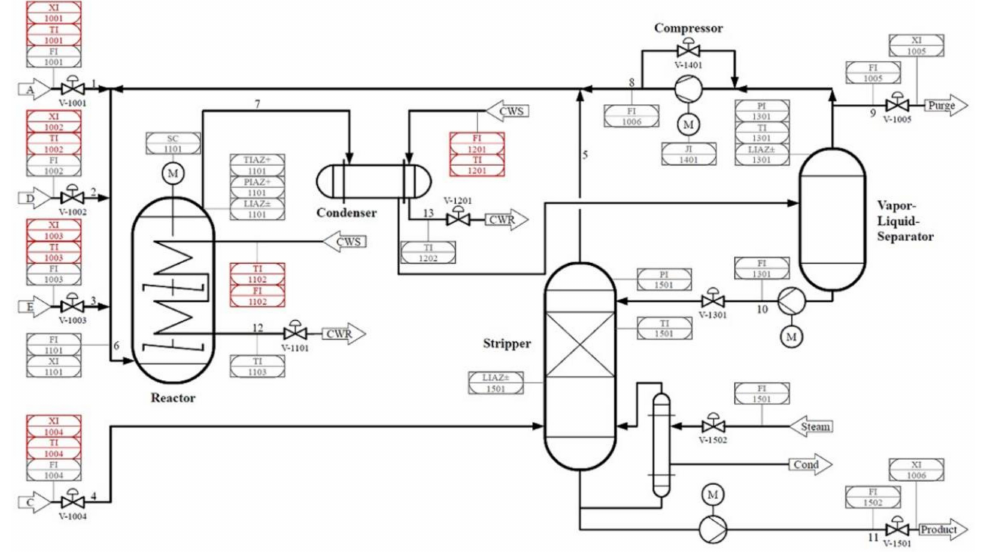
Figure 6. The flowchart of the Tennessee Eastman (TE)